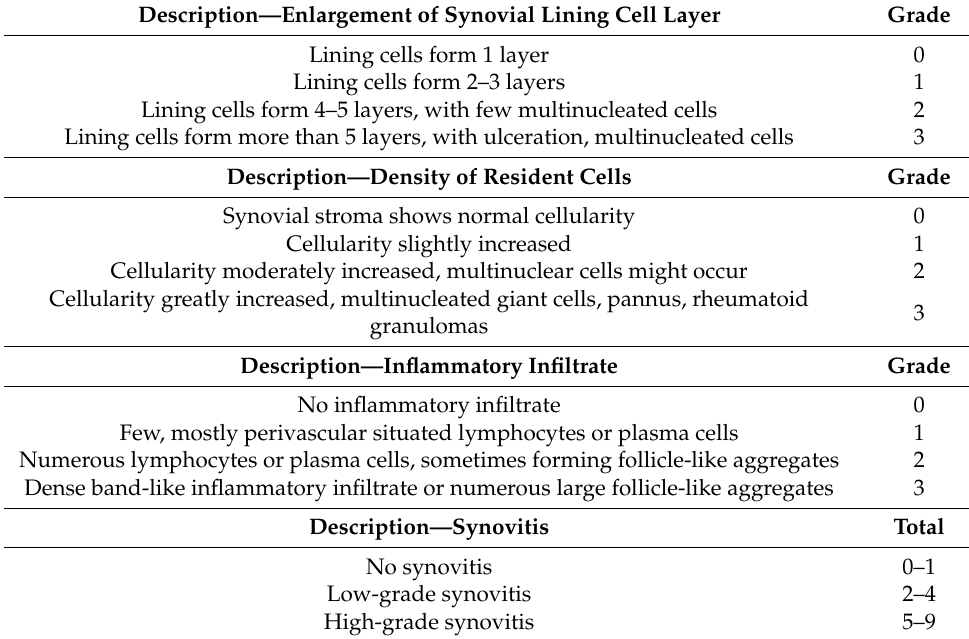
Table A5. Modified Rooney synovitis scoring scale. Indications of synoviocyte hyperplasia, fibrosis, proliferating blood vessels, perivascular and diffuse lymphocyte infiltrates, and focal lymphocyte aggregates were evaluated by three investigators. A consensus score was reported for each